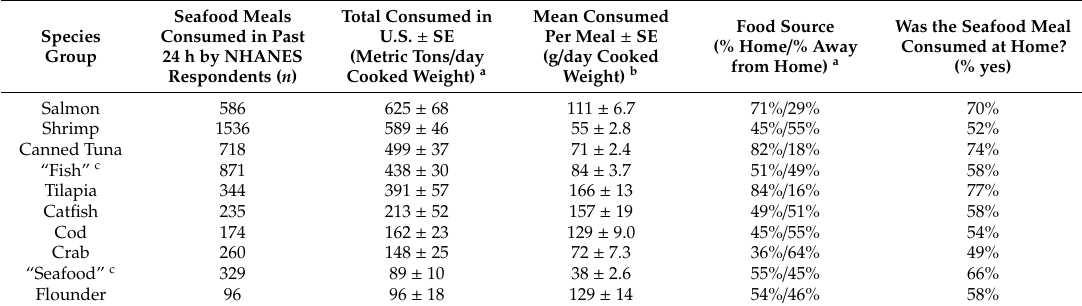
Table 3. Top seafood species consumed by United States adult seafood consumers ( ≥ 19) (NHANES 2007 to